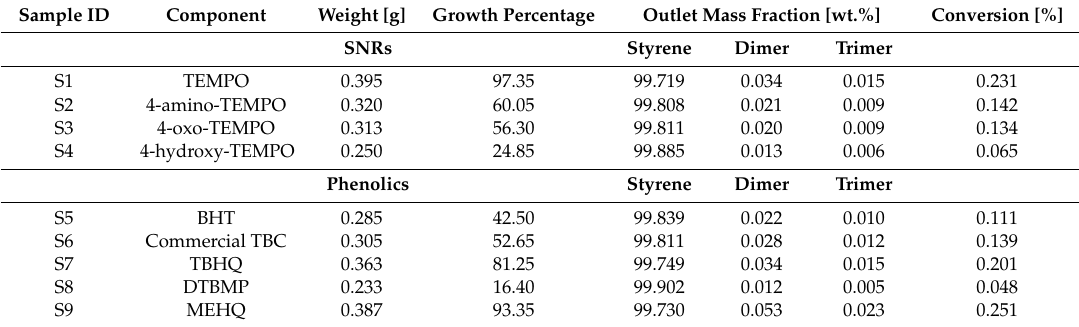
Table 3. Measured weights of polymer and the growth percentage in the presence of inhibitors after 4 h.